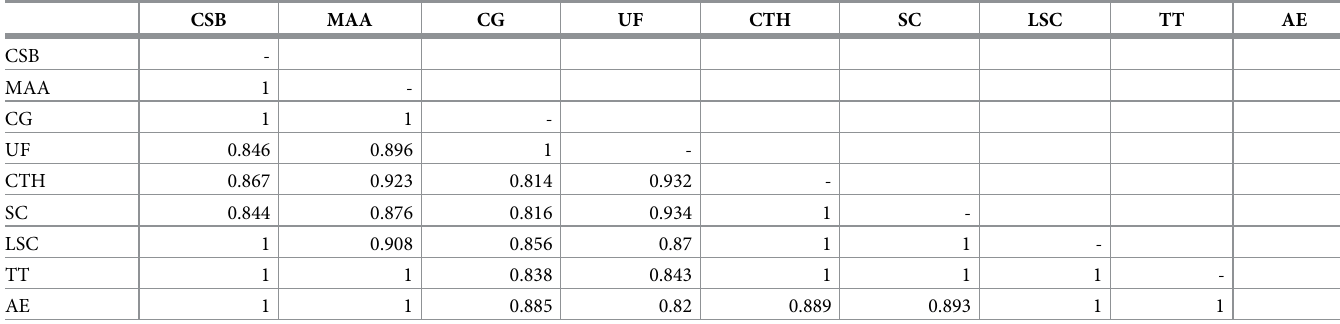
Table 3. Covariances in the nine factor model of the